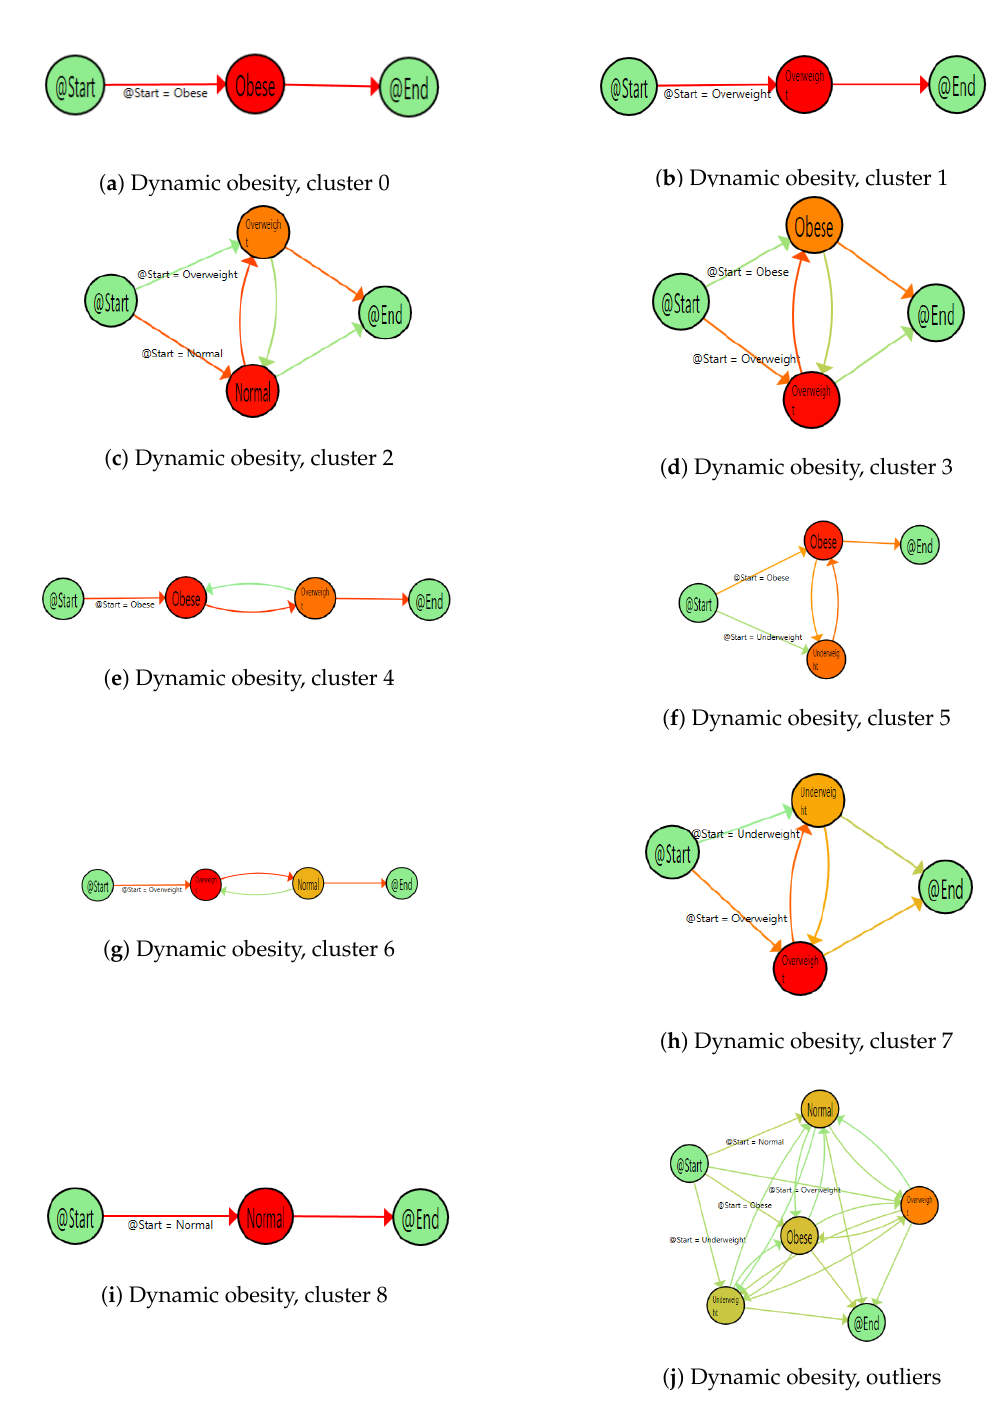
Figure 3. Dynamic characterisation of